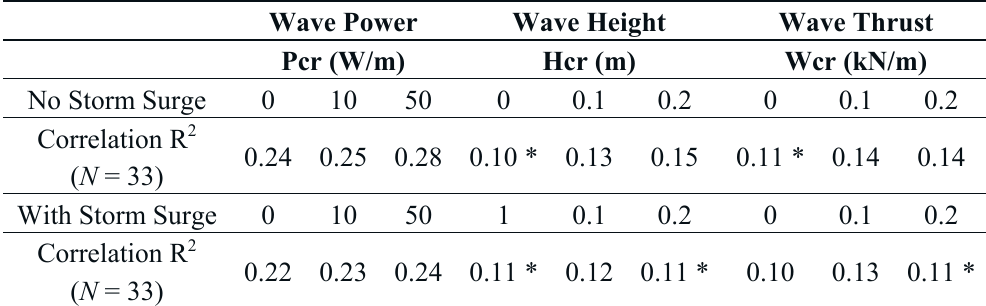
Table 2. Summary of correlation coefficients to show the strength between GIS-derived erosion rates and thresholds in the wave variable (meaning values below the threshold are discarded from the computation; see Equations 2) with and without the effects of storm